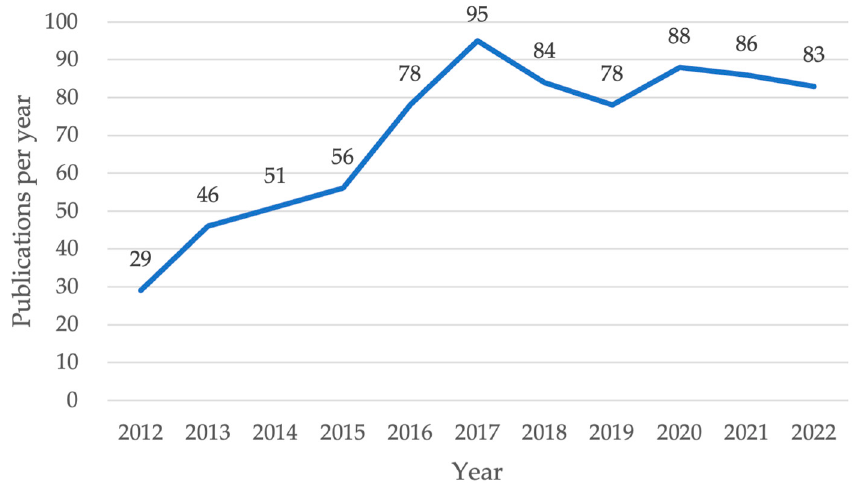
Figure 2. Publications per year.